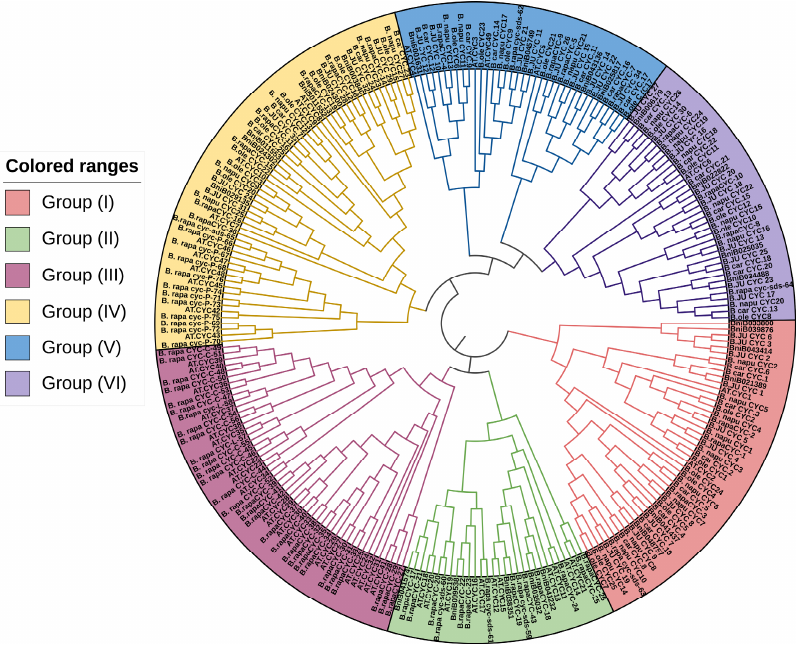
Figure 3. Phylogenetic tree analysis of the cyclins retrieved in Brassica rapa , Arabidopsis thaliana, Brassica napus, Brassica oleracea, Brassica juncea, Brassica carinata and Brassica nigra . ClustalW was used to align the full protein sequences of 76 cyclins, and MEGA X was used to create a phylogenetic tree using the neighbor-joining method with 1000 bootstrap repetitions. Based on the nomenclature of the Arabidopsis cyclins (from A-, B-, and D- plant-specific cyclins), all cyclins were divided into six unique groups and were differentiated by distinctive colors.